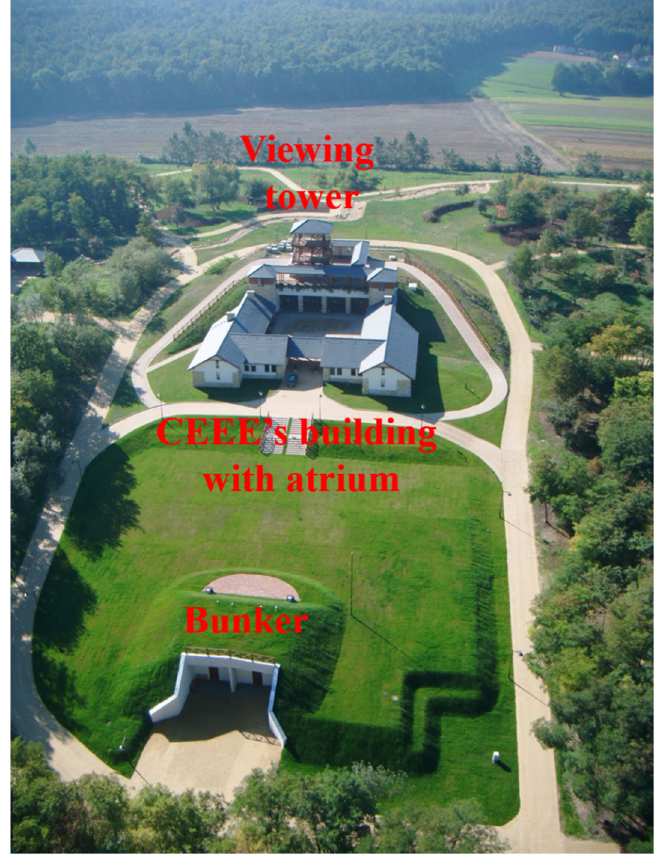
Figure 2. The Silesian Botanical Garden’s seat at the building of Centre for Ecological and Environ- mental Education (CEEE), on the So ś nia Góra in Miko ł ów, Poland (source: phot. of Janusz Moczulski, 2013); available thanks to 2013 Pawe ł Kojs’ permission).